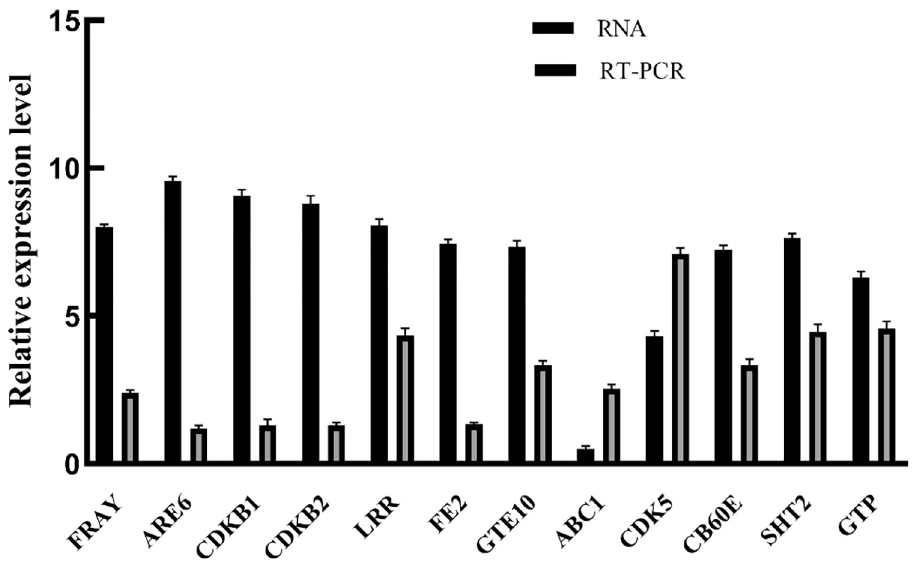
Fig 7. Expression patterns of genes related to growth and development of diploid and triploid tea leaves analyzed by